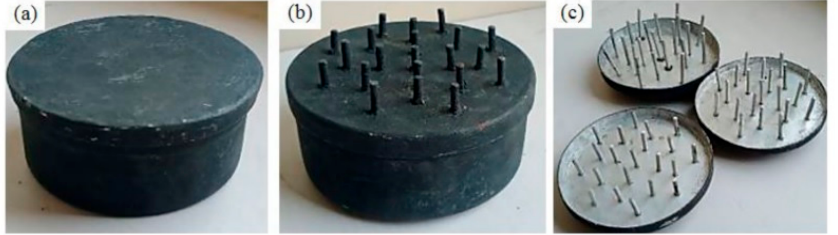
Figure 16. Diagram of fins of varying sizes used over vessels. ( a ) Without fins; ( b ) Finned cooking vessel; ( c ) Finned lids (inside view). Reprinted/adapted with permission from Ref. [45], 2021, Else- vier.